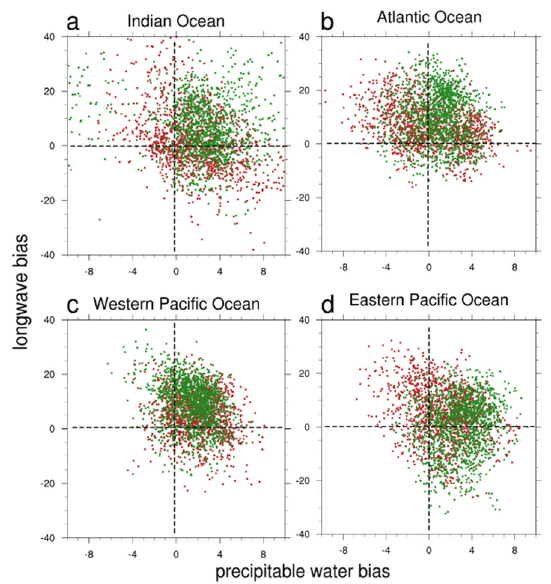
Figure 10. Relationship between bias in the total cloud cover (%) and bias in Q LW (W m − 2 ) over the ( a ) Indian (40 ° E–100 ° E), ( b ) Atlantic (70 ° W–10 ° E), ( c ) western Pacific (100 ° E–160 ° E ), and ( d ) eastern Pacific Oceans (120 ° –70 ° W) during December-January-February (DJF, red) and June-July-August (JJA, green).